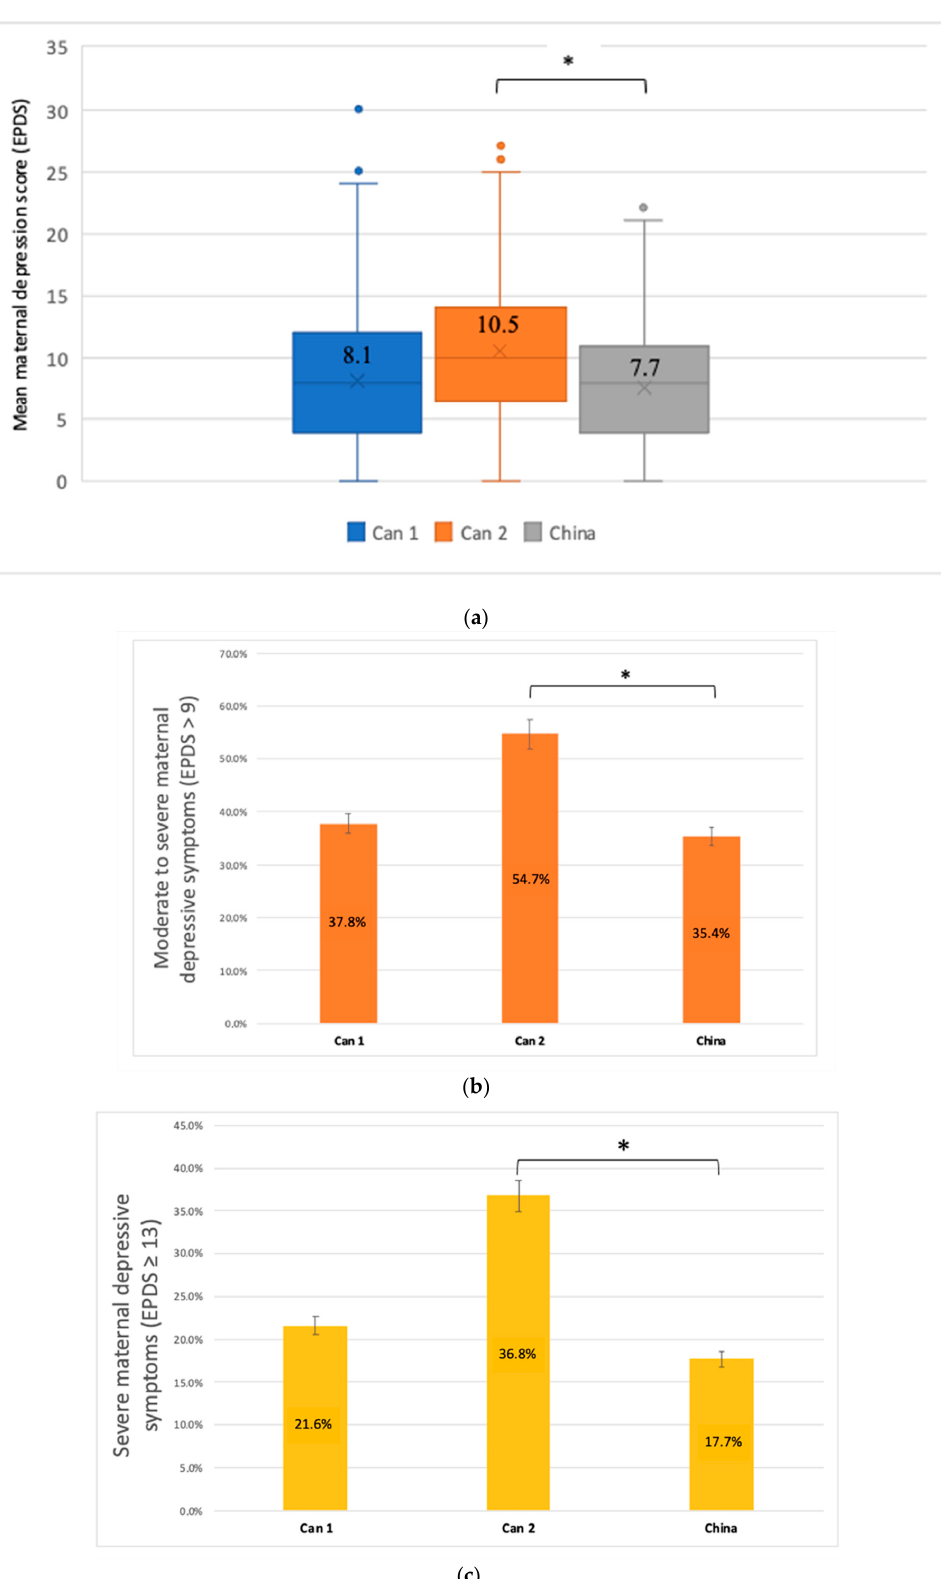
Figure 2. ( a ) Maternal depression using the Edinburgh Postnatal Depression Scale (EPDS). p = 0.16 (between Canada 1/China)/ p = 0.005 (between Canada 2/China). Canada 1 (Can1), n = 1592; Canada 2 (Can2), n = 117; China, n = 413; missing values: Canada 1, n = 212; Canada 2, n = 18; China, n = 71. * p < 0.05. Can 1: Canada 1/Can 2: Canada 2. ( b ) Moderate to severe maternal depressive symptoms using the Edinburgh postnatal depression scale (EPDS) cut-off (>9). p = 0.92 (between Canada 1/China)/ p < 0.001 (between Canada 2/China); * p < 0.05. Can 1: Canada 1/Can 2: Canada 2. ( c ) Severe maternal depressive symptoms using the Edinburgh postnatal depression scale (EPDS) cut-off ( ≥ 13). p = 0.08 (between Canada 1/China)/ p < 0.001 (between Canada 2/China); * p < 0.05. Can 1: Canada 1/Can 2: Canada 2. Maternal anxiety symptoms, measured with the GAD-7 scale, also varied across co- horts (Figure 3a). Indeed, the overall mean maternal anxiety score was 4.0 (SD, 3.8). The lowest maternal anxiety score was reported in China (2.6 [SD, 2.9]) when compared to the Canada 1 cohort (4.3 [SD, 3.8]) ( p < 0.001) and when compared to Canada 2 cohort (5.8 [SD, 5.2]) ( p < 0.001) (Figure 3a). The prevalence of moderate to severe anxiety (GAD-7 > 9) was lower in China (0.9%) compared to the Canada 1 cohort (8.9%) ( p < 0.001) and the Canada 2 cohort (15.7%) ( p < 0.001) (Figure 3b). Severe maternal anxiety symptoms are presented in Figure 3c. The prevalence of severe anxiety (GAD-7 > 15) was (2.5%) in the Canada 1 cohort and (10.4%) in the Canada 2 cohort. It is important to note that no Chinese partici- pants had severe anxiety at the time of recruitment.